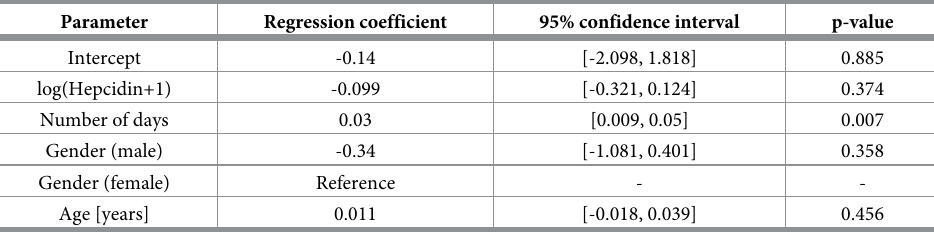
Table 3. Multivariable regression analysis of delta